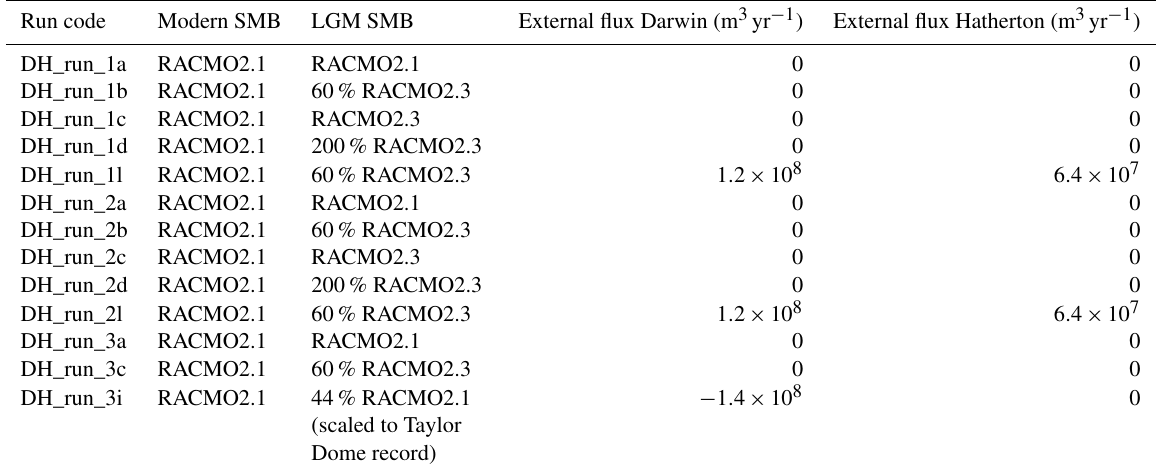
Table 1. Inputs for flowband model